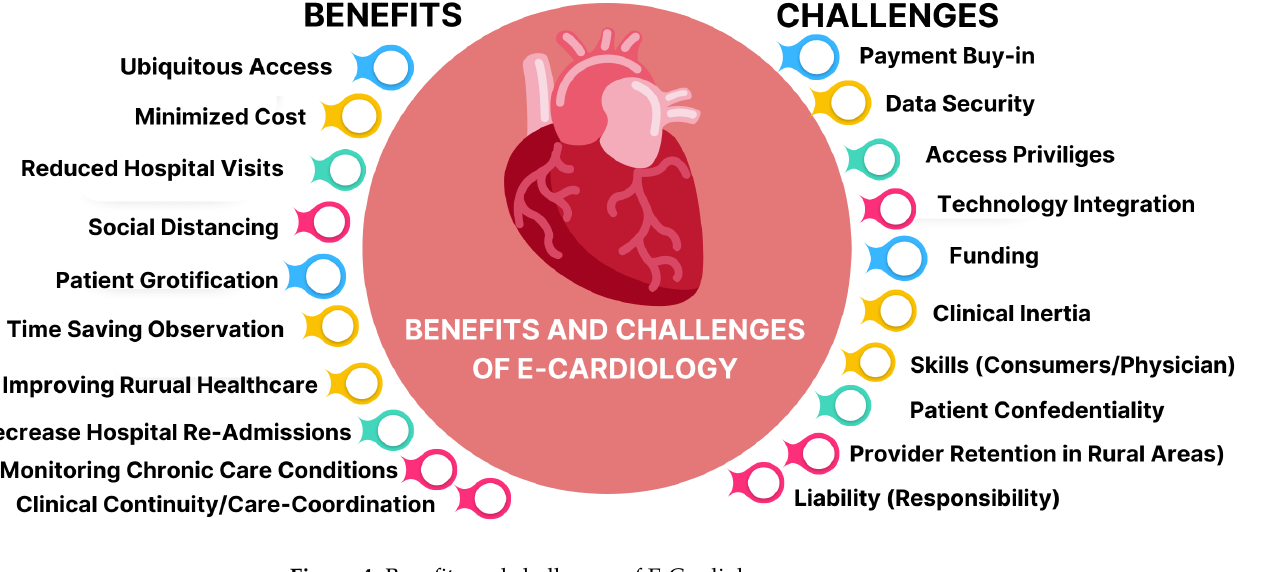
Figure 4. Benefits and challenges of E-Cardiology.